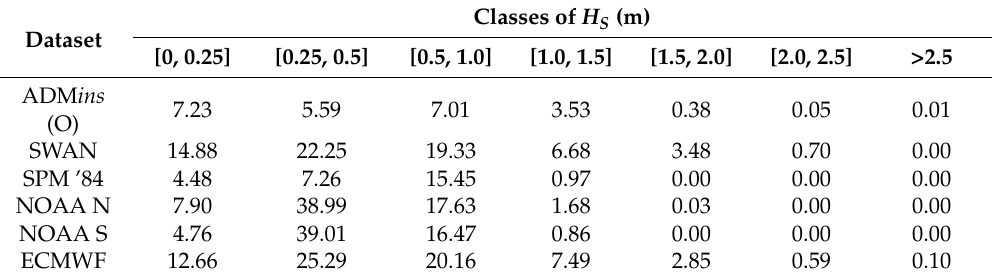
Table 4. NW af , for classes of H s